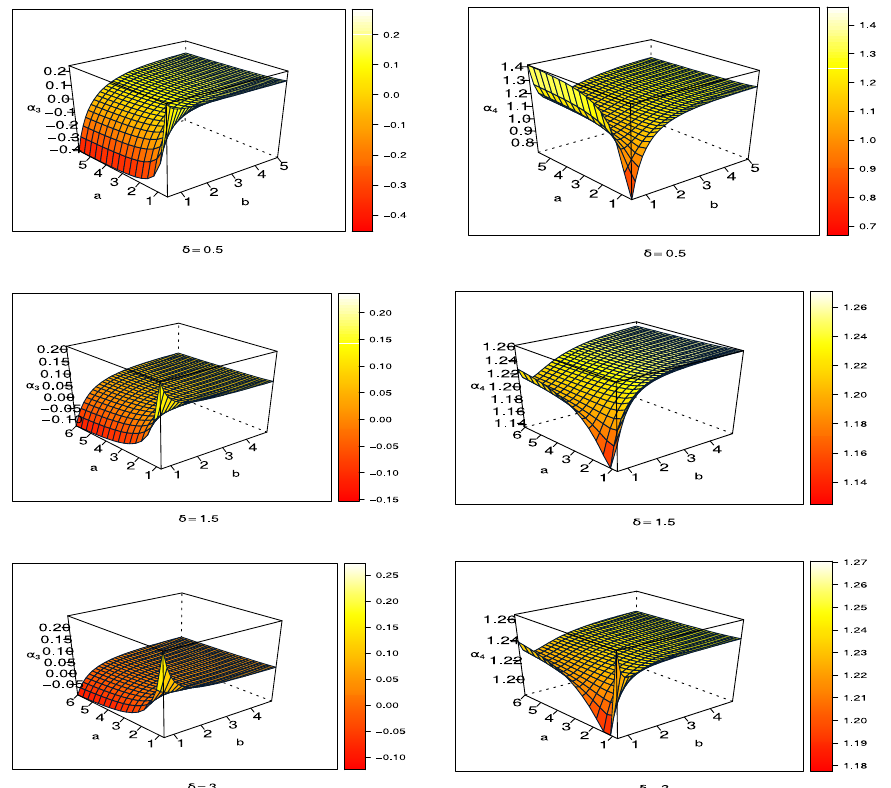
Figure 3. coe ffi cient of skewness and kurtosis for UPBXD. Figure 3. Coefficient of skewness and kurtosis for